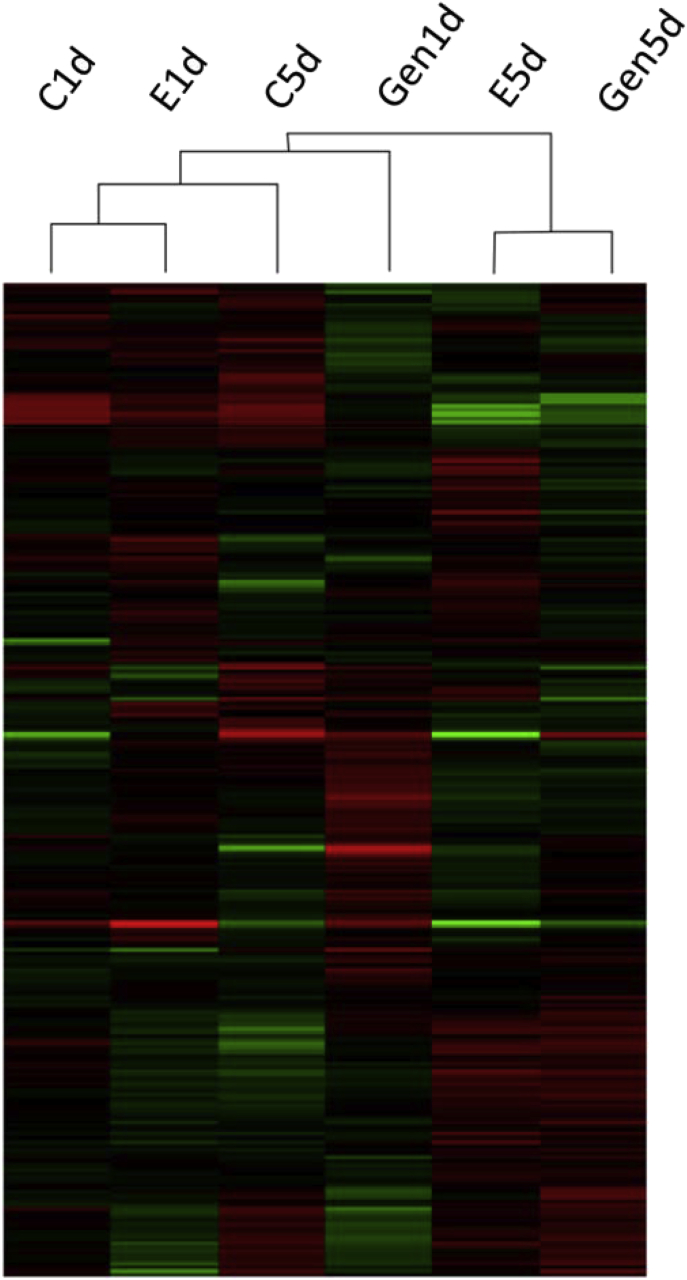
Heatmap of clustered DE genes identified in sea bass scales after treatment with E2 or Gen. The tree in the upper panel shows the hierarchical clustering of the DE genes (one gene/line) identified in the scales of the six treatment groups [injections with estradiol (E), genistein (G) or vehicle only (control, C) at 1 or 5 days (1d or 5d)]. The red gradient indicates high abundance, the green gradient indicates low abundance and black indicates equal abundance for each gene and condition relative to the average. 1 day after treatment the DE genes of the E2 group clustered more closely to the control than Gen1d. 5 days after treatment both E2-and Gen-treated scales clearly separated from the control and clustered together, suggesting a similar response at this time point.